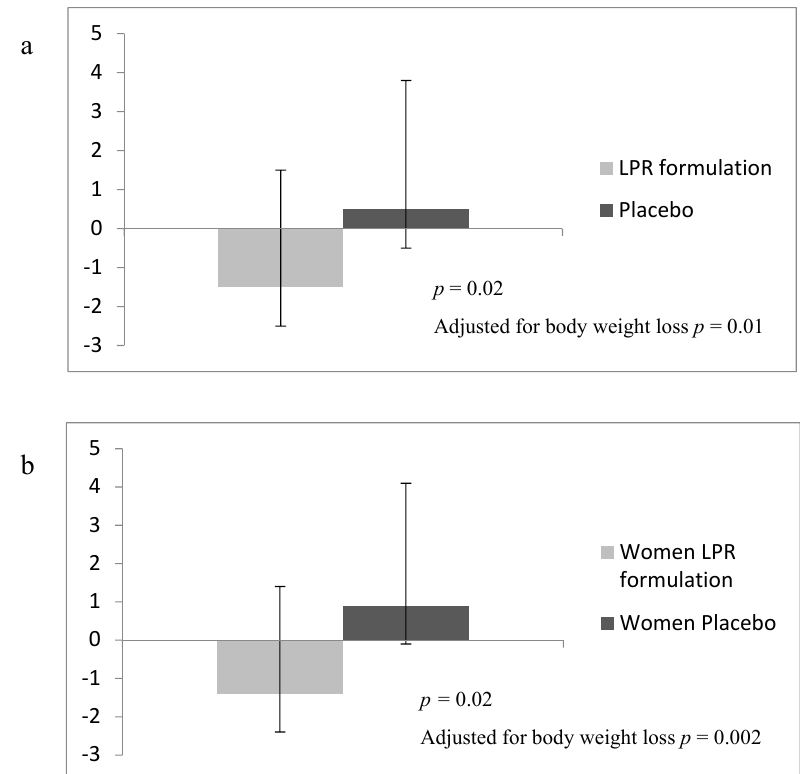
Figure 1. Variation in BDI scores between LPR formulation and placebo groups in ( a ) men and women and ( b ) women only. Values are means ± standard error of the mean. Results represent the variation of the BDI scores over the duration of the entire program.